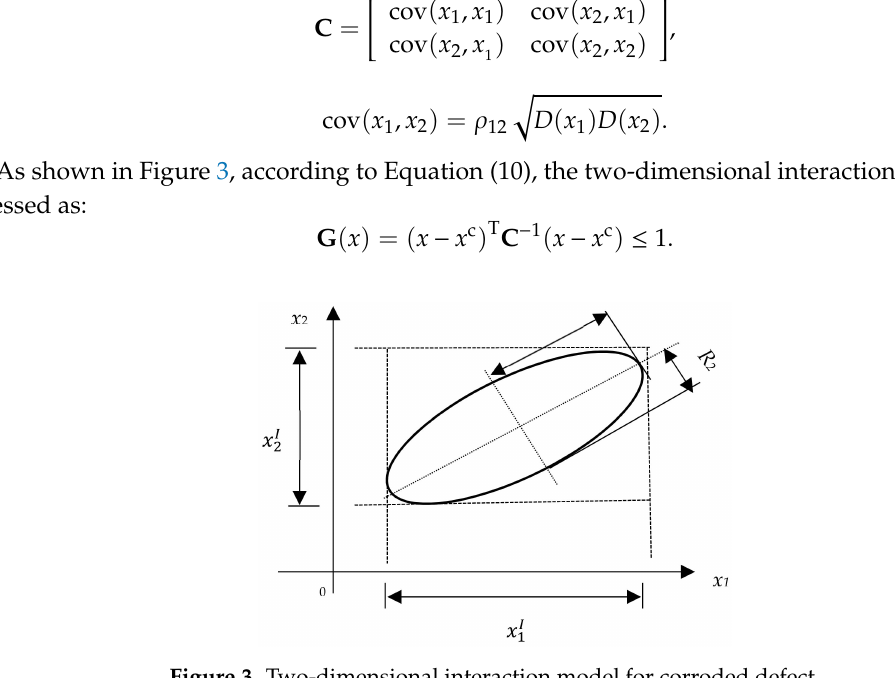
Figure 3. Two-dimensional interaction model for corroded